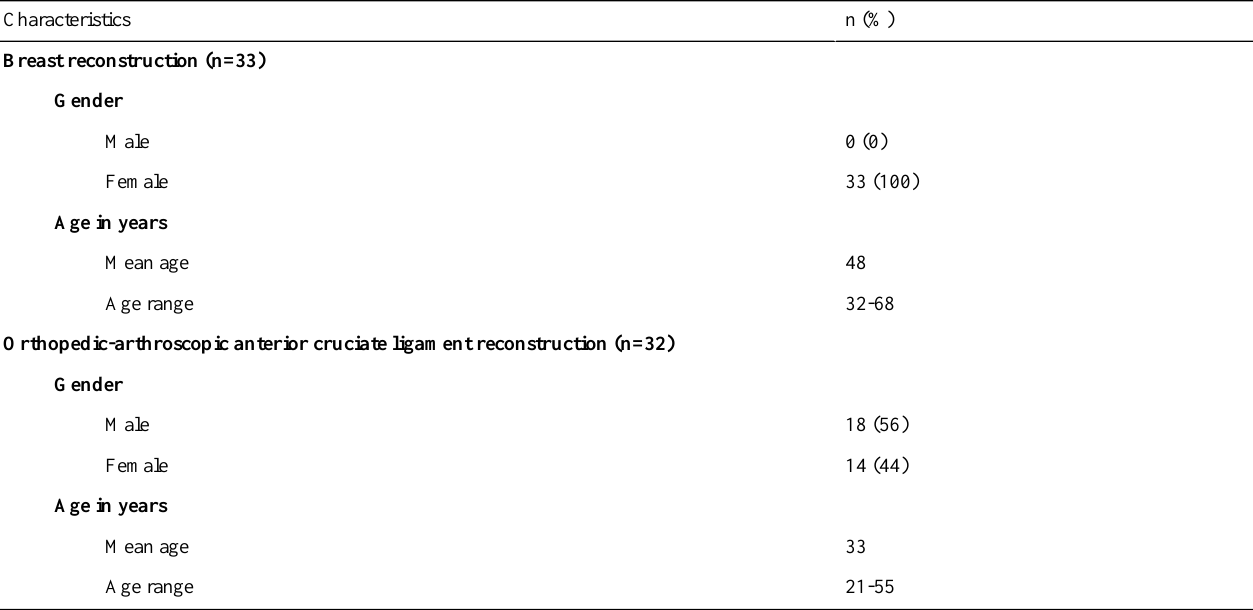
Table 2. Patient demographic